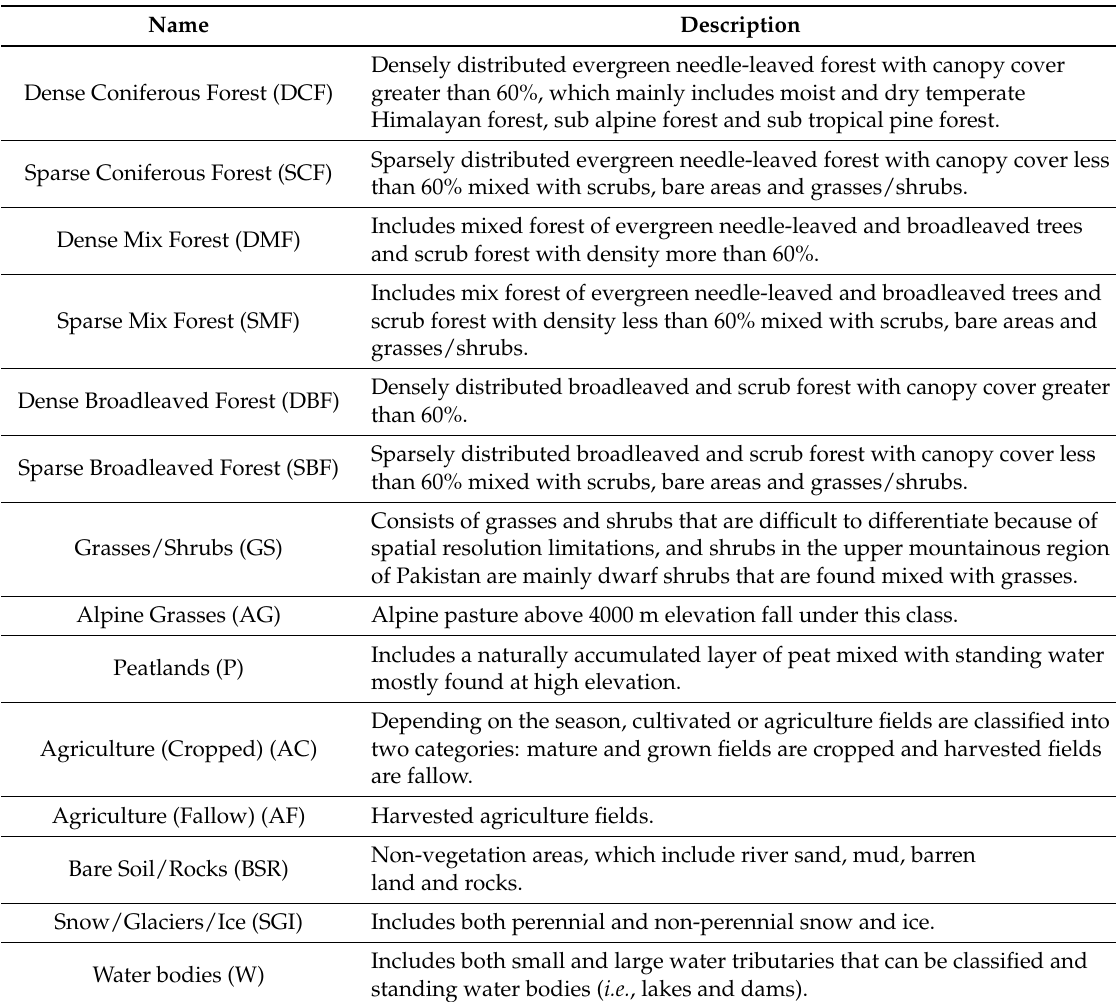
Table 1. Land cover classes used in the